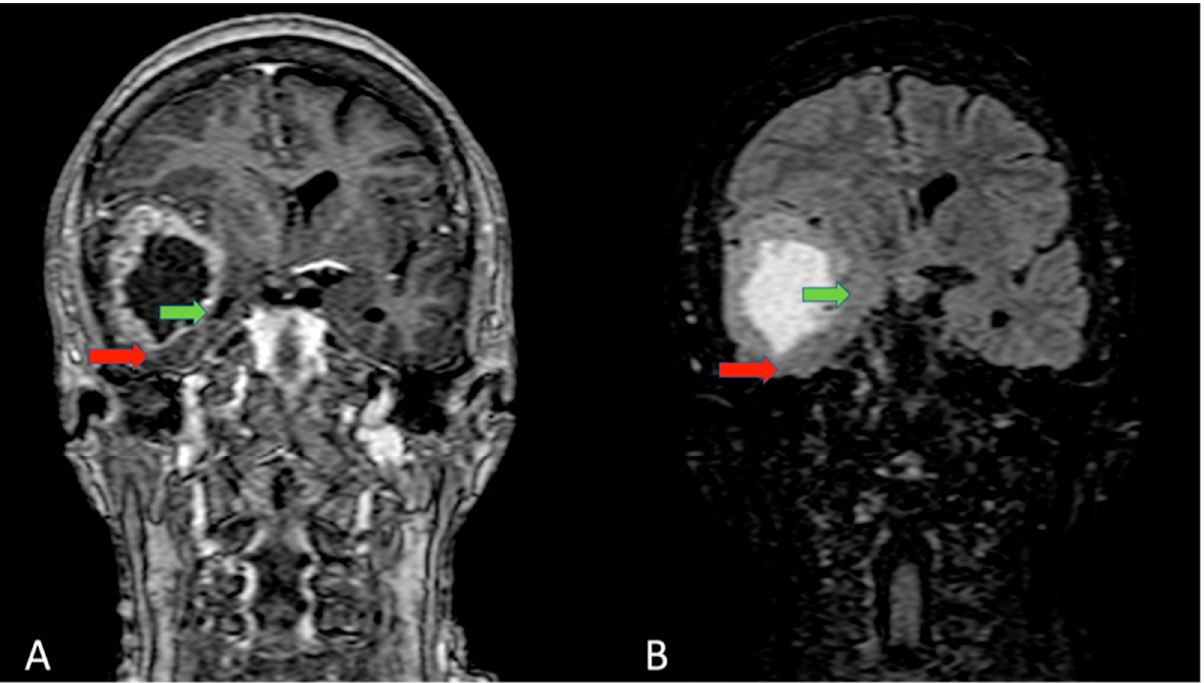
Figure 1. Coronal section of an MRI T1 with gadolinium ( A ) and FLAIR sequences ( B ). GBM arises and grows into the lateral compartment of the right temporal lobe (middle temporal gyrus), compressing and dislocating the superior temporal gyrus and sparing the inferior temporal gyrus, fusiform gyrus (red arrow), and parahippocampal gyrus (green arrow).